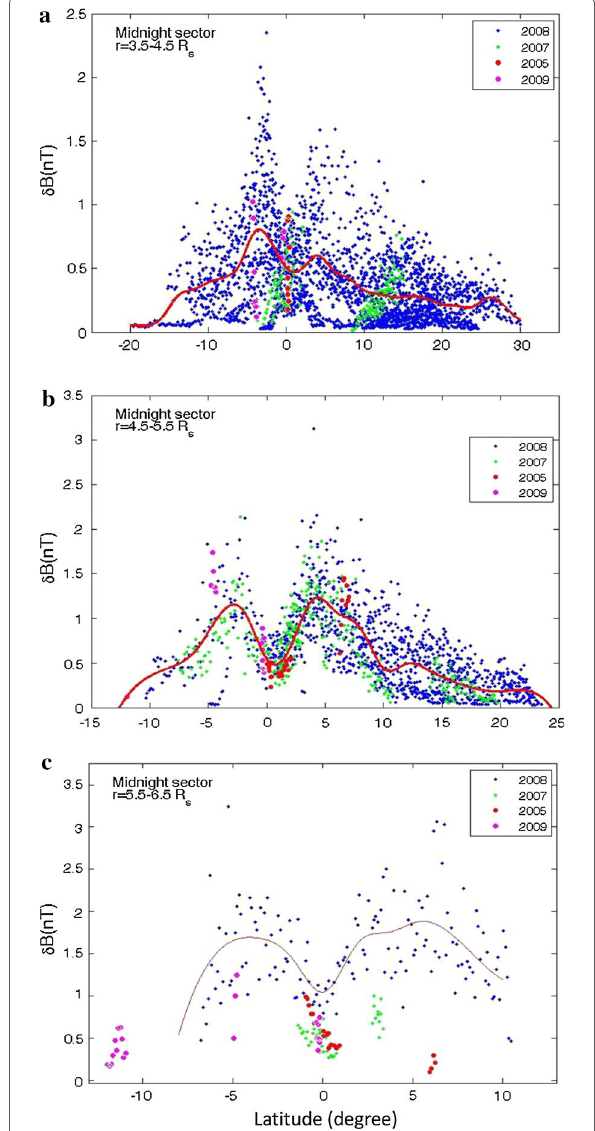
Fig. 10 The latitude dependence of the averaged perturbed mag- netic field amplitude δB in the radial distance range of a 3.5–4.5 R S , b 4.5–5.5 R S and c 5.5–6.5 R S for the midnight sector for the data from 2005, 2007, 2008 and 2009. Each point represents the averaged δB within a small region of Δ θ 0.1° and Δ R 1 R s when Cassini passed = = through